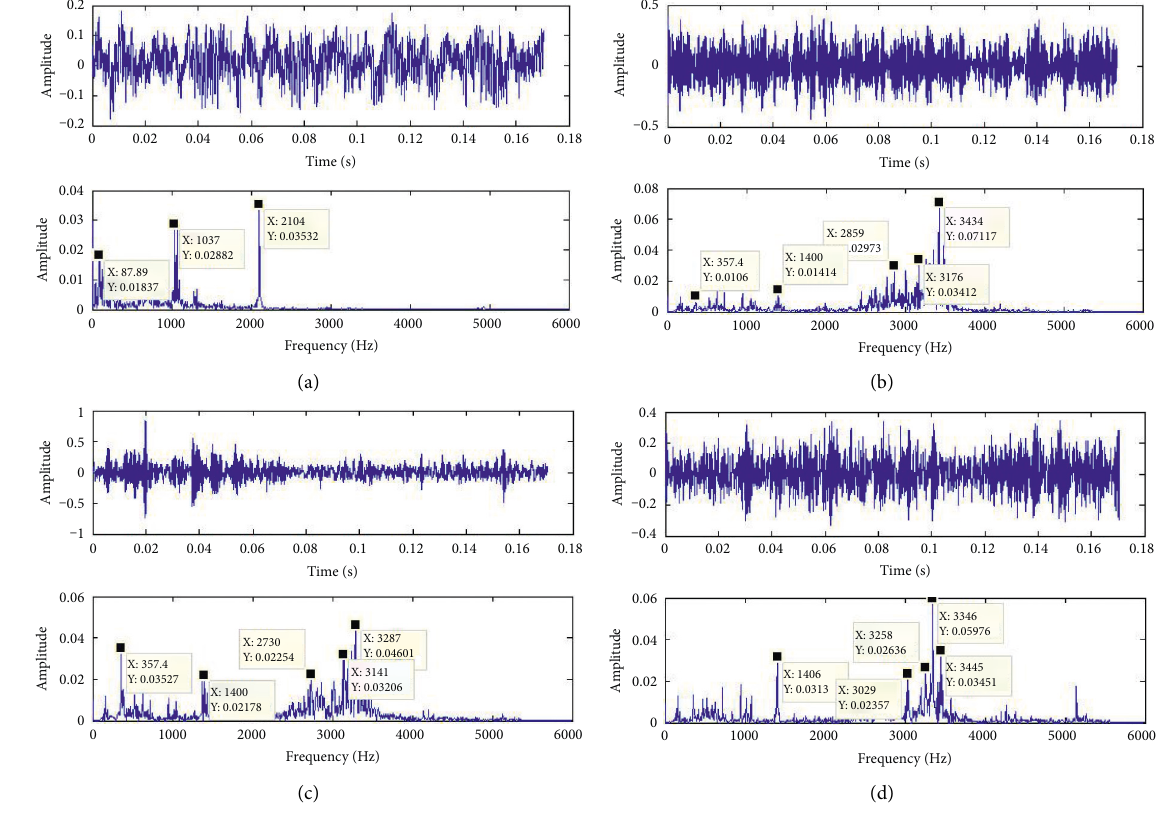
Figure 7: Time domain waveform and spectrum of rolling element with different damage degree. (a) Normal state. (b) Slight damage of rolling element. (c) Moderate damage of rolling element. (d) Serious damage of rolling